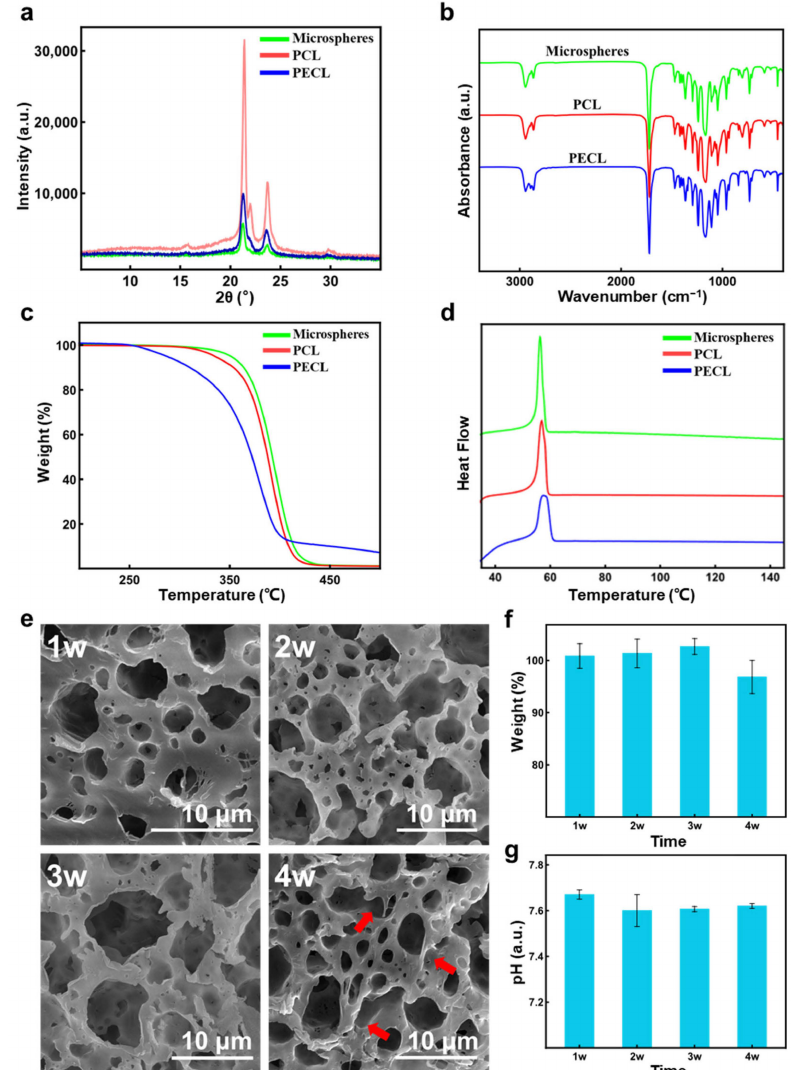
Figure 6. ( a – d ) The results of XRD, FTIR, TGA, and DSC test of PCL porous microspheres, PCL and PECL; ( e – g ) the changes of morphology ( e ) and weight of microspheres ( f ) as well as pH changes of degradation liquid ( g ) during the in vitro